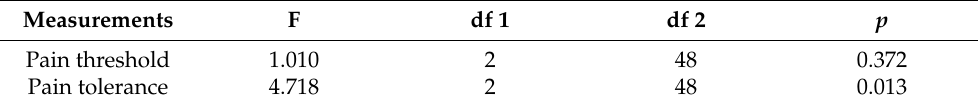
Table 5. Fixed effects of setting on pain threshold and tolerance in non-responders.